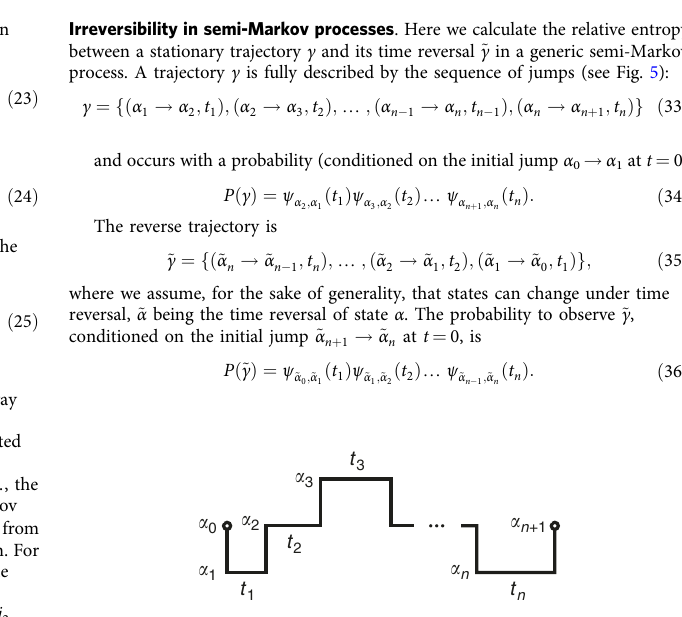
Fig. 5 A trajectory γ of a semi-Markov